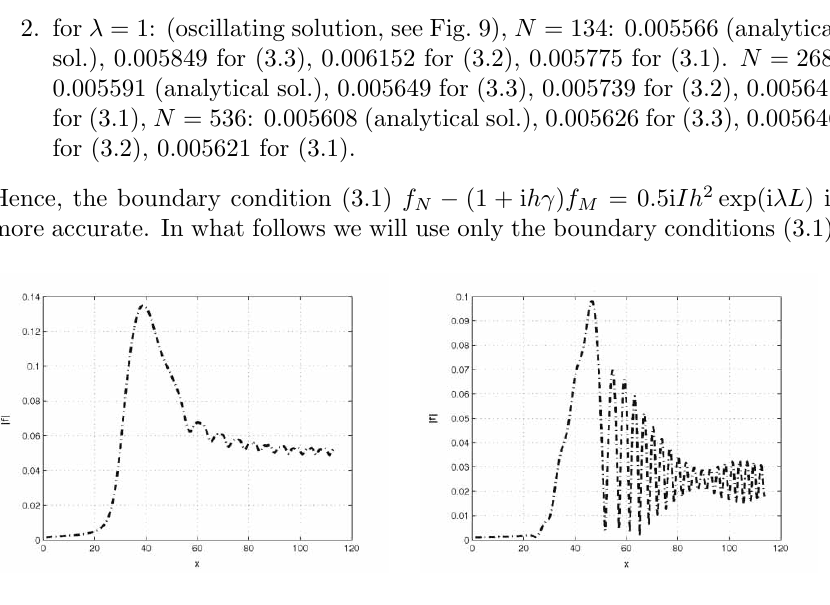
Figure 10. Stationary solution | f | (new), λ = 0, L = 113 . 7, N = 134.